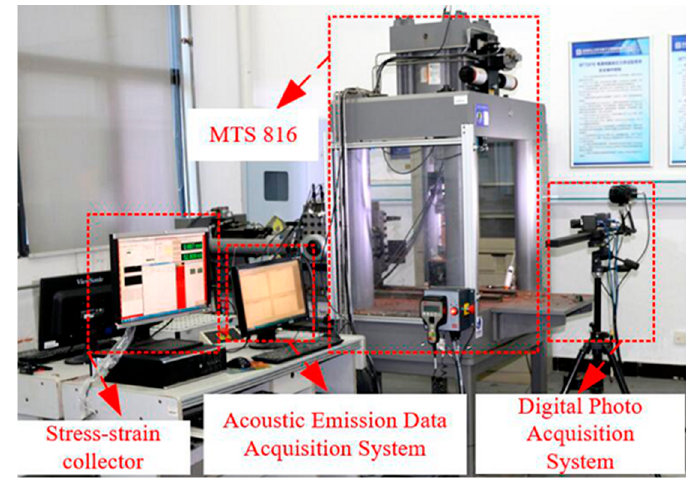
Figure 4. Loading and data acquisition system.